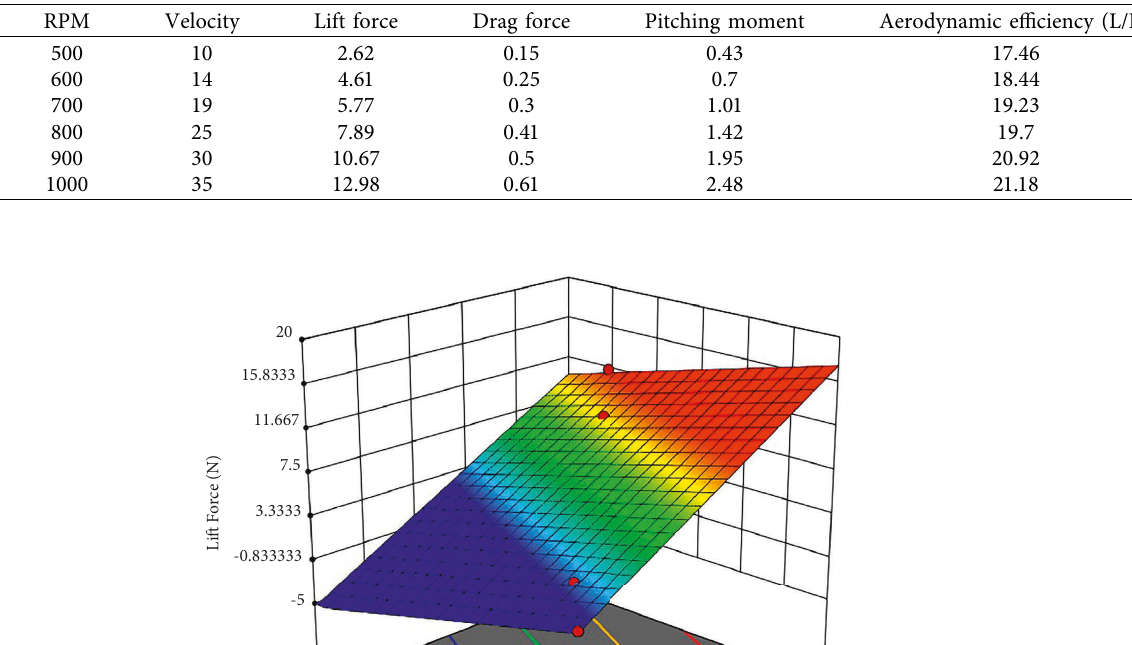
Table 6: Wind tunnel readings for the NASA SC(2)-0714 model.